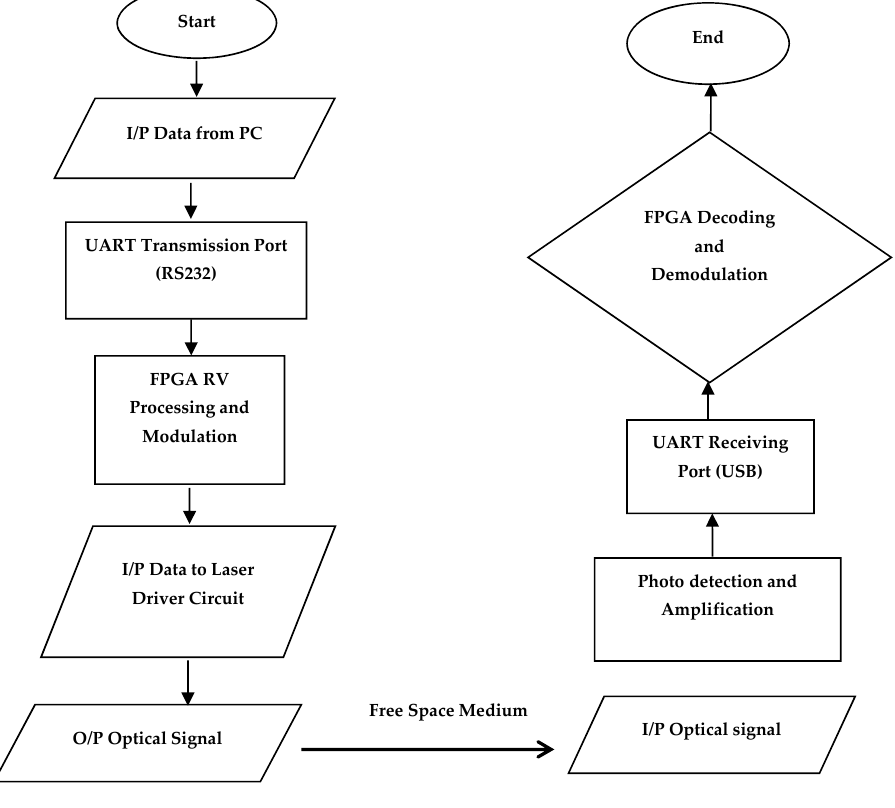
Figure 13. System